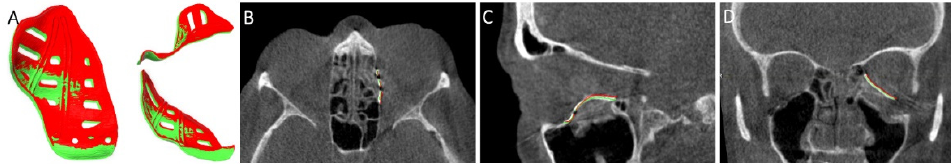
Figure 8. Illustration of an evaluation. ( A ) Three-dimensional model of the planned patient-specific implant (red) and the realized patient-specific implant (green) viewed from different perspectives. ( B – D ) Axial, sagittal, and coronal view of the postoperative computed tomography scan with the planned contour of the patient-specific implant in red.